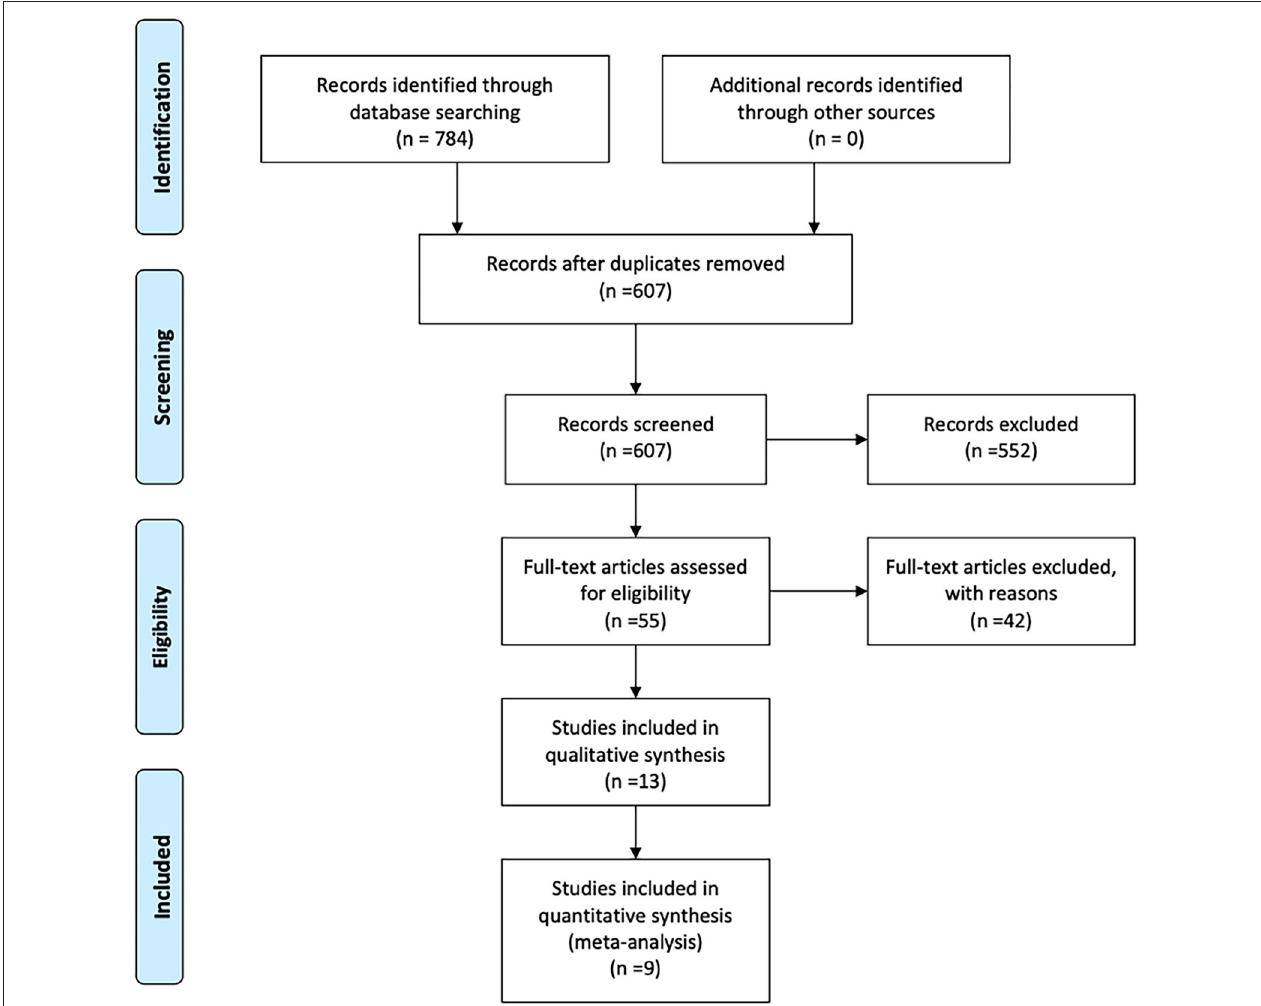
FIGURE 1 | Flowchart of the study selection